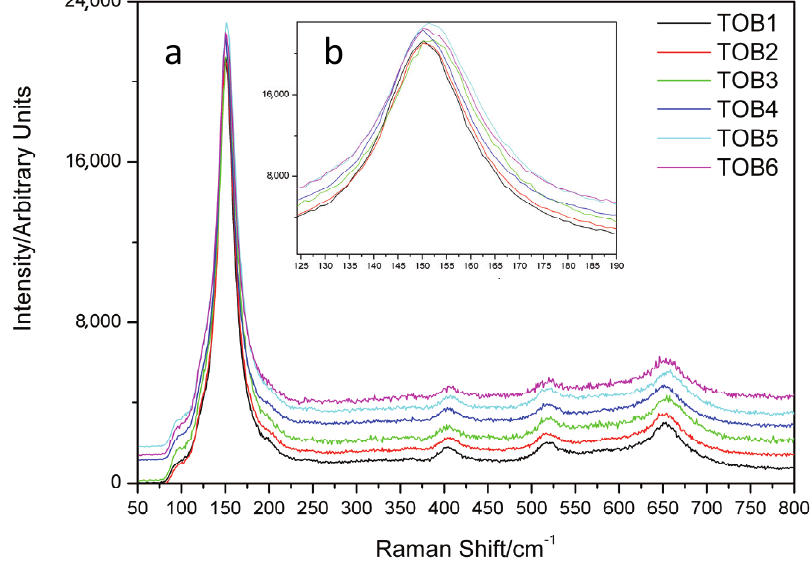
Figure 4. FTIR spectra of the TiO